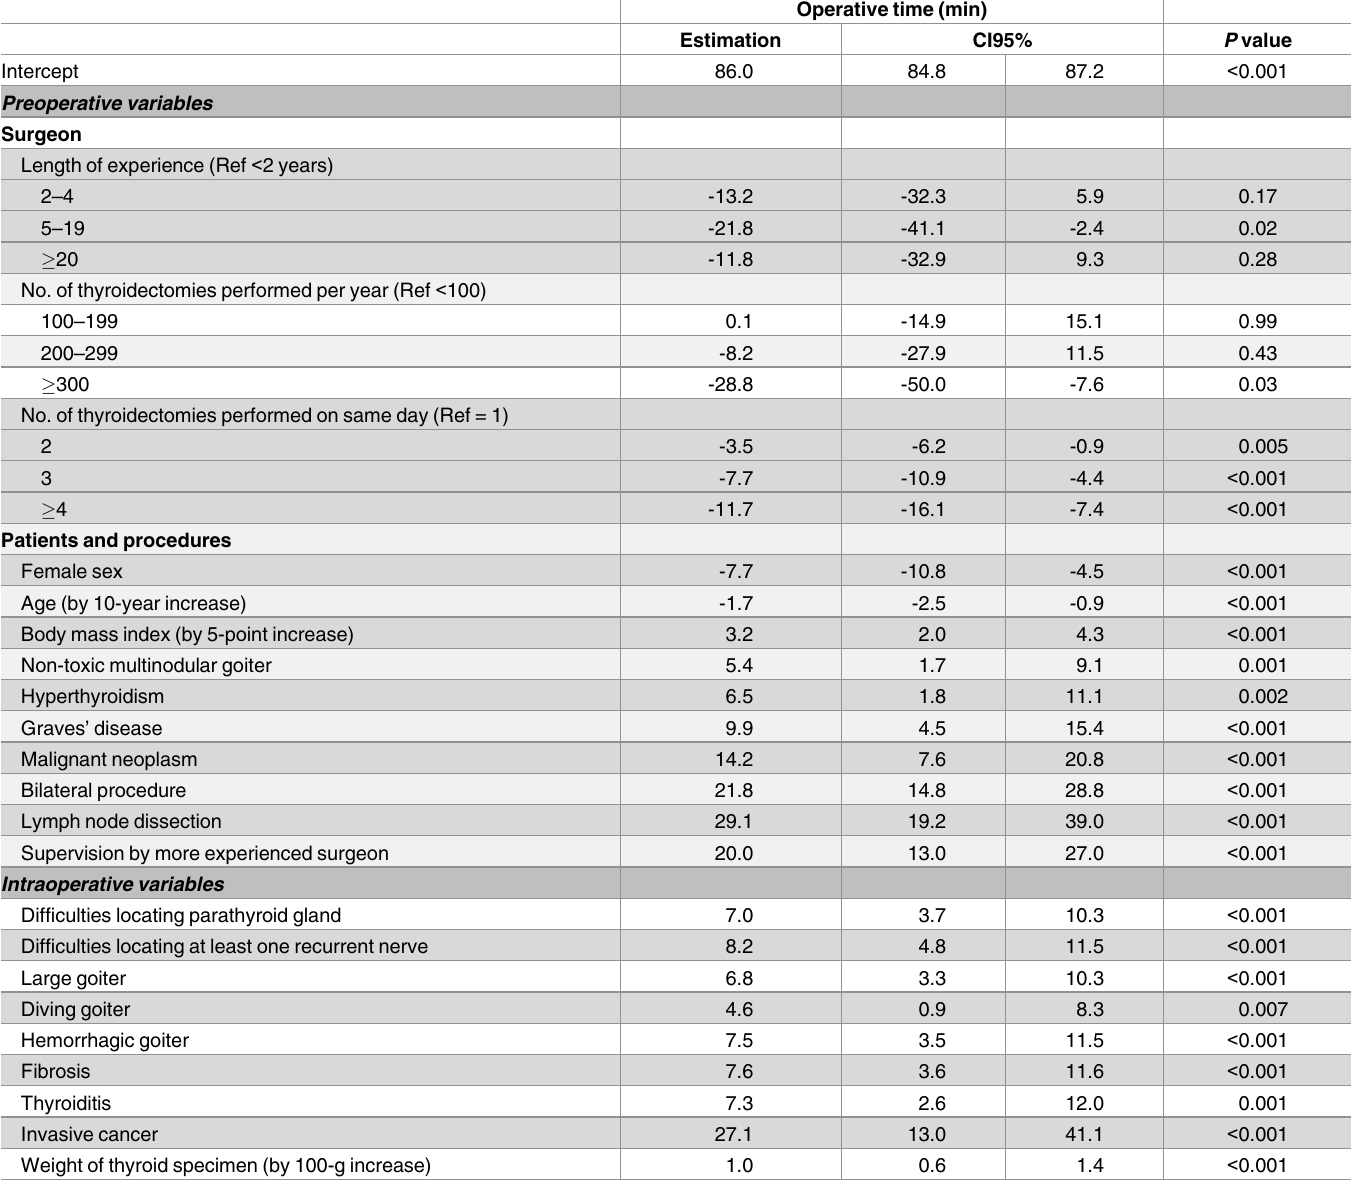
Table 2. Factors independently associated with operative